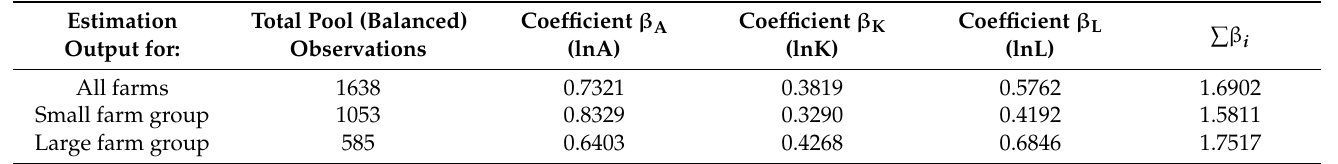
Table 3. Results of pool estimation * for small, large, and all farm